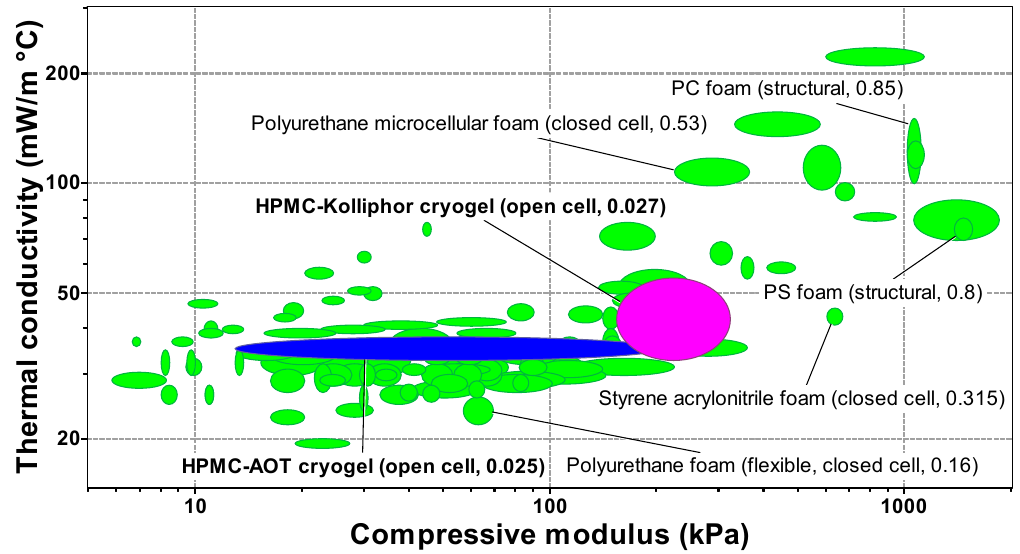
Figure 6. Ashby chart of thermal conductivity vs. compressive modulus obtained by the software CES Edupack 2019 ® at a level 3 showing 106 classes of materials belonging to the family of foams. The numbers in the parenthesis correspond to the relative density, which is the apparent density divided by the density of bulk material; the density of bulk HPMC amounts to 1326 kg/m 3 . The blue and magenta regions were introduced in the chart to show the position of the cryogels prepared with hydrogel precursors containing Kolliphor ® EL and AOT, respectively.